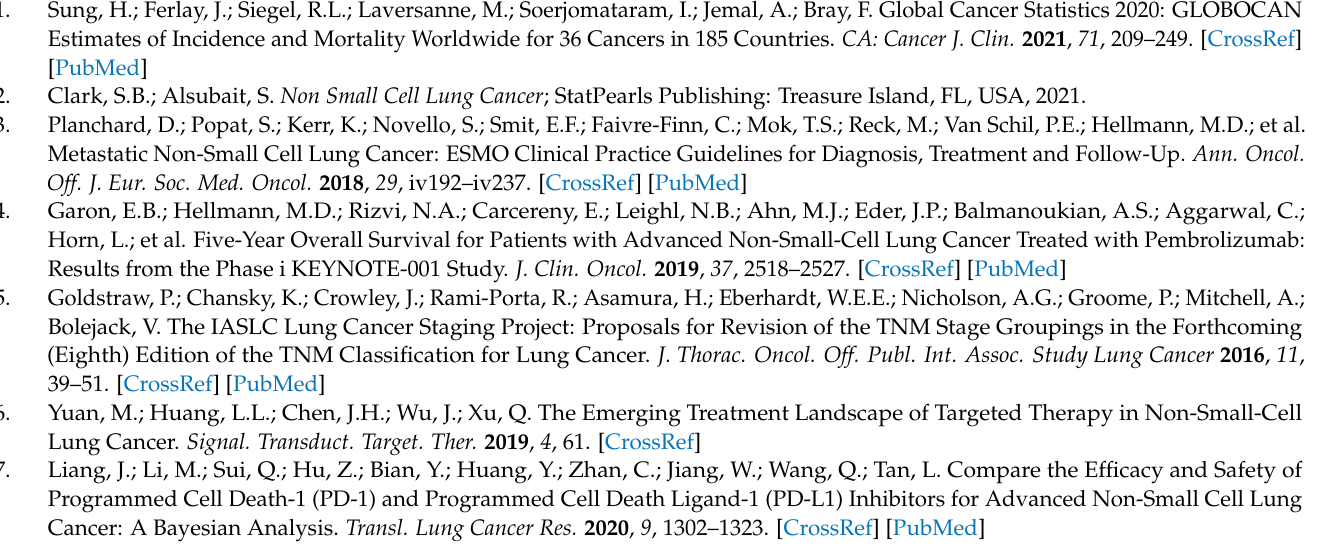
any grade between immunotherapy treatments. Table S8: League table showing the RRs and CI 95% for nephritis increased